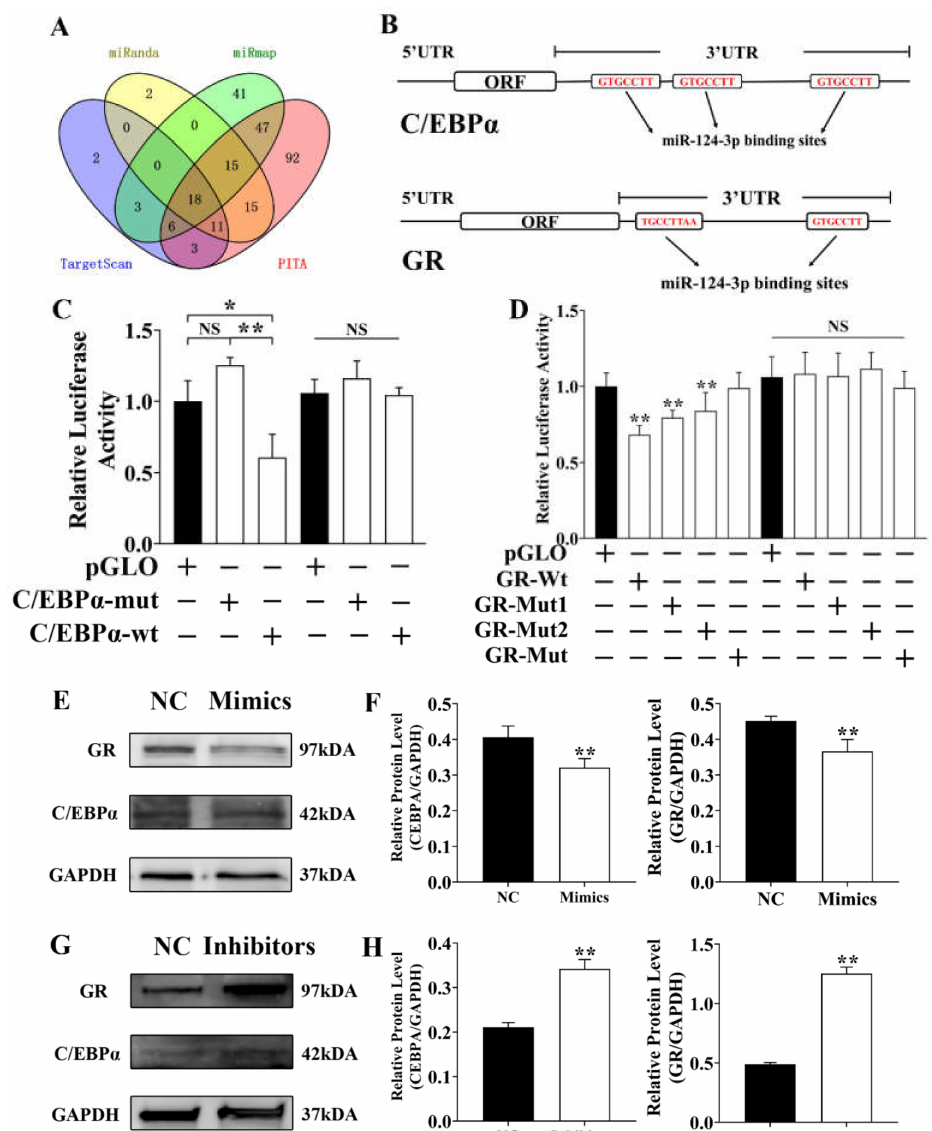
Figure 6. Ssc-miR-124 suppressed GR and C/EBP α by targeting their 3 (cid:48) UTR. ( A ) The Venn diagram of ssc-miR-124 targets by 4 prediction software. ( B ) The schematic diagram of ssc-miR-124 miRNA response elements (MREs) of C/EBP α and GR genes. ( C , D ) Relative luciferase activity of constructed pmirGLO vector that contained the C/EBP α 3 (cid:48) UTR and GR 3 (cid:48) UTR, which respectively contained ssc-miR-124 wild or mutated binding site sequences. ( E , F ) Western blotting result of C/EBP α and GR in pre-adipocyte after transfecting ssc-miR-124 mimics for 48 h ( E ), and the relative quantification of their WB results used ImageJ software ( F ). ( G , H ) Western blotting results of C/EBP α and GR in pre-adipocyte after transfecting ssc-miR-124 inhibitors for 48 h ( G ), and the relative quantification of their WB results using ImageJ software ( H ). Data are presented as mean ± s.e.m. * means P < 0.05, ** means P <